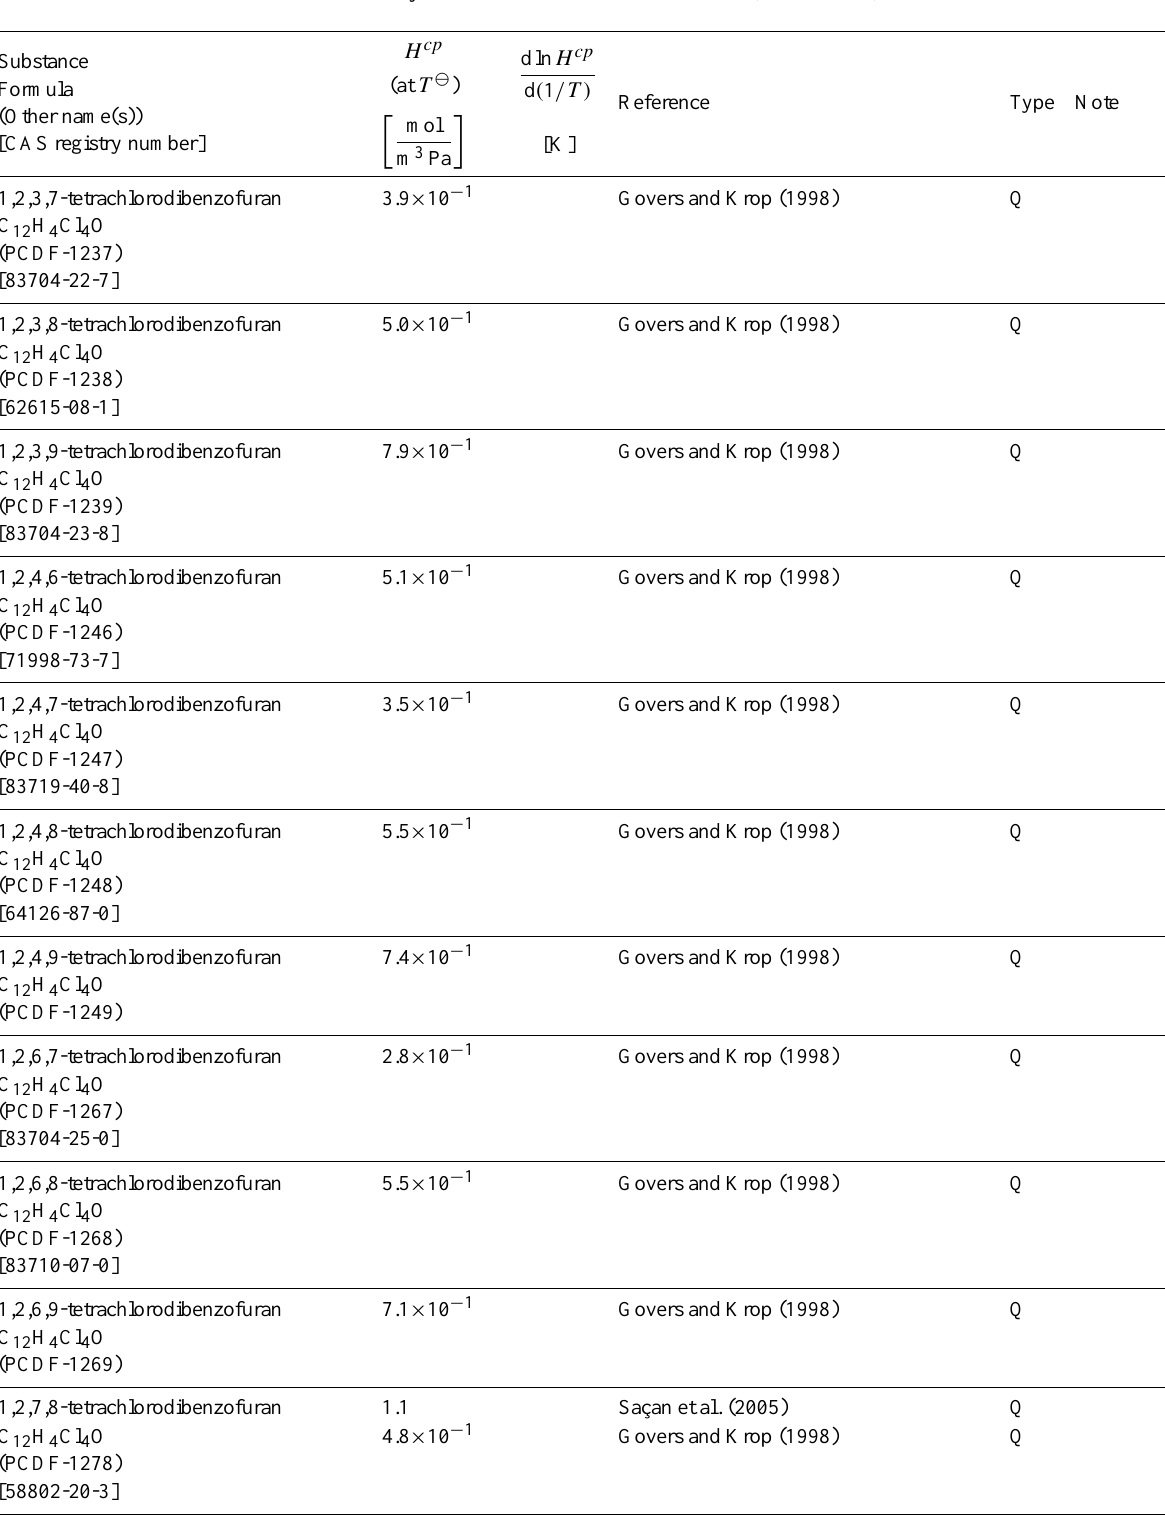
Table 6: Henry’s law constants for water as solvent